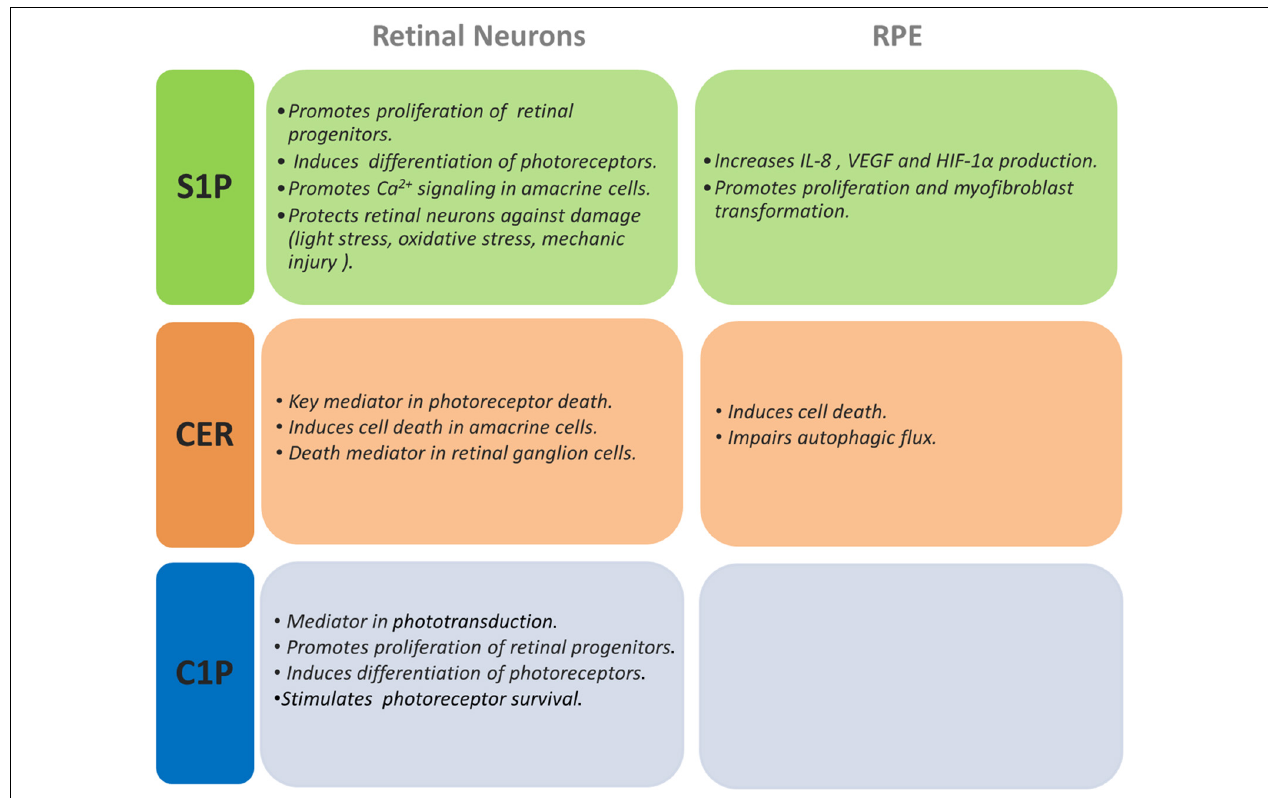
FIGURE 3 | Actions of S1P, Cer, and C1P on retinal neurons and RPE cells. This figure summarizes the effects shown for S1P, Cer, and C1P on different retinal neurons and RPE